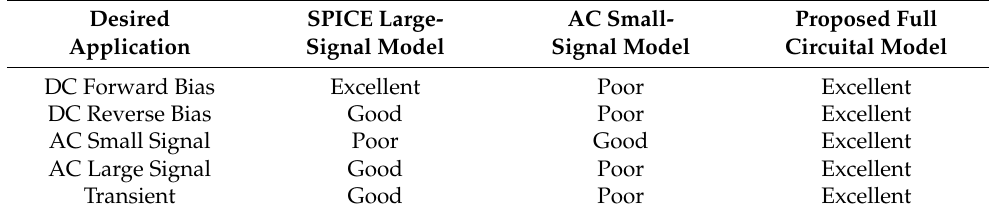
Table 2. A high-level summary of the suitability of the discussed models for different applications. Desired SPICE